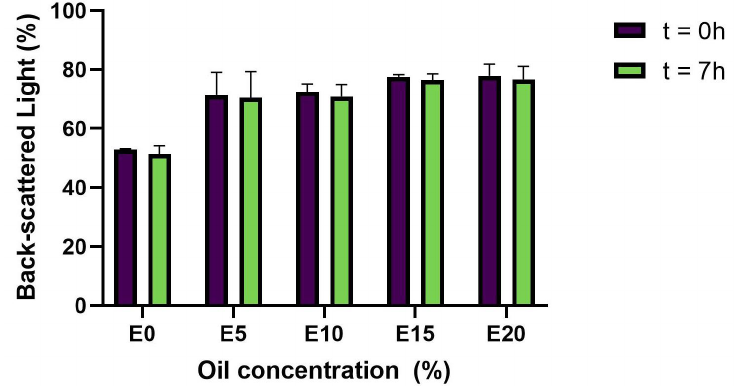
Figure 2. Back-scattered light in PPI emulsions at t = 0 h and t = 7 h under storage at room temperature. Sample name corresponds to its oil content, e.g., E0: 0% oil, E5: 5% oil, etc.